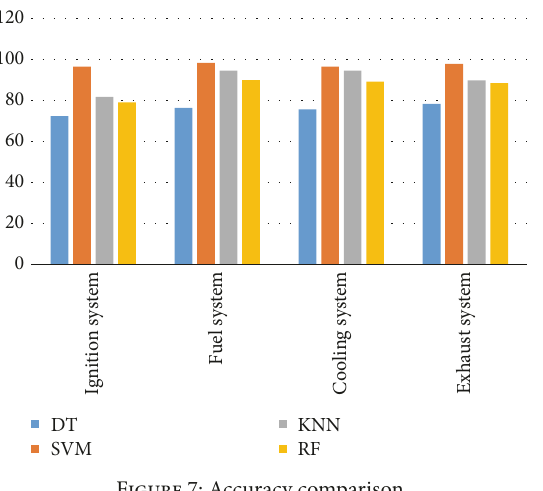
Figure 7: Accuracy comparison.